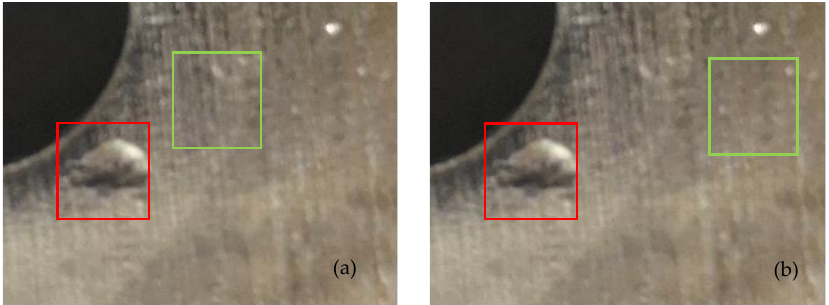
Figure 10. Comparison of the distance between the prediction box and ground-truth frame. ( a ) The real defect is close to the predicted defect. ( b ) The real defect is far from the predicted